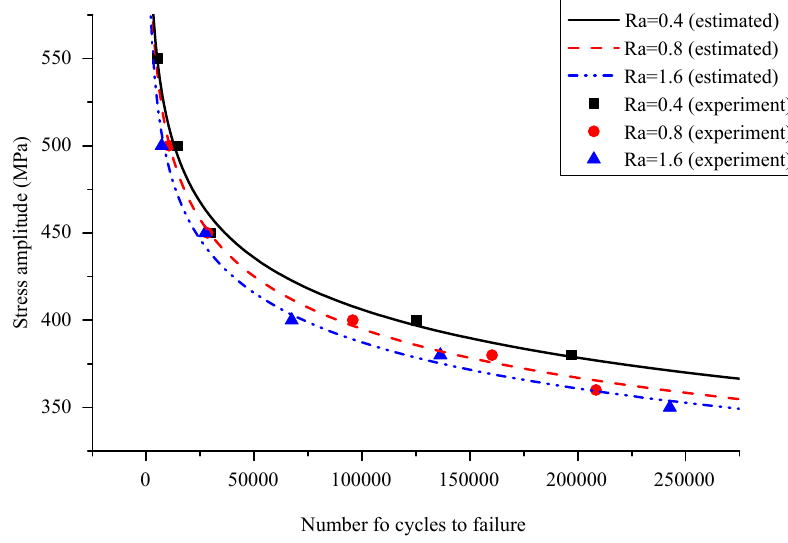
Figure 9. Estimated mean fatigue life curves and the experiment values. Table 8. Validation experiment